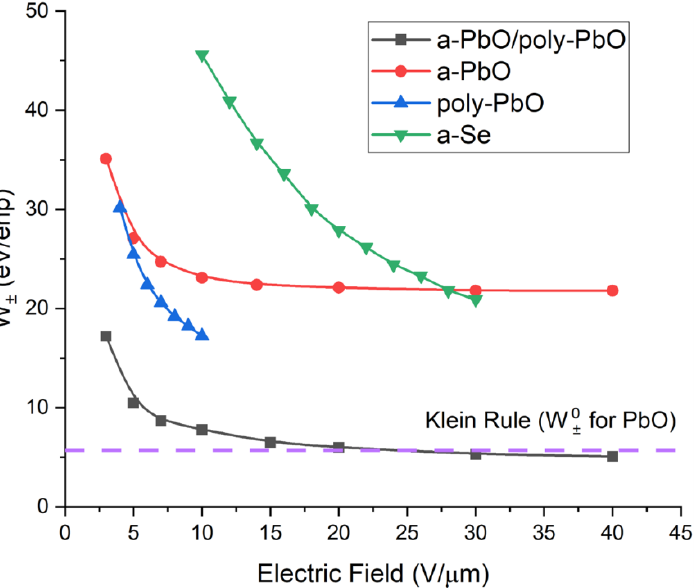
Figure 4. W ± at various operational electric fields for photoconductive materials of interest. Data for a-PbO, poly-PbO, and a-Se were extracted from Refs. [18,22,42], respectively.